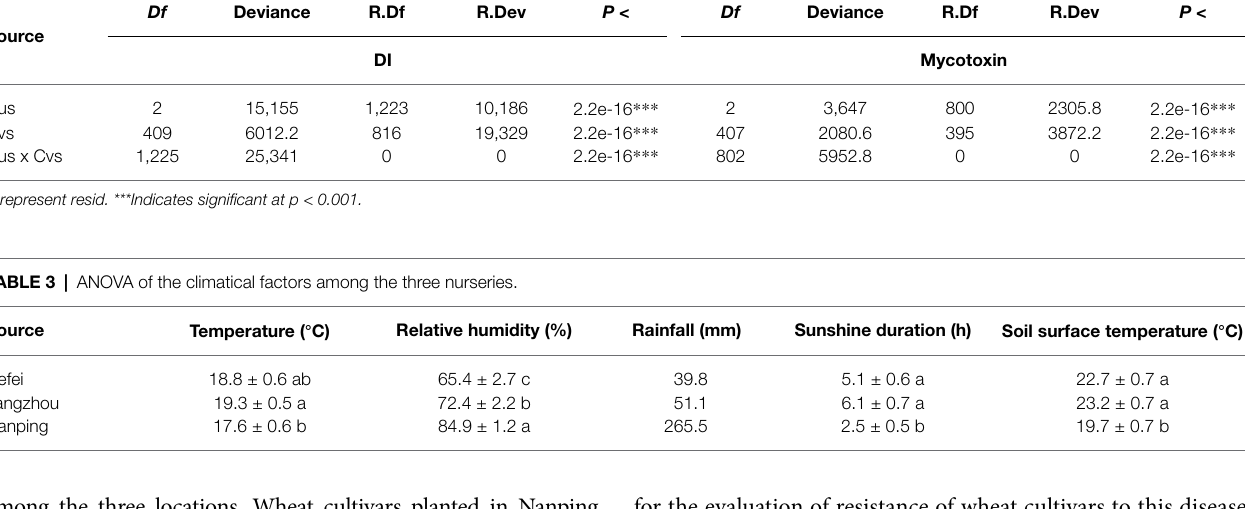
TABLE 2 | Effect ( p -value) of cultivars (Cvs) and nurseries (Nus) on severity and mycotoxins level.